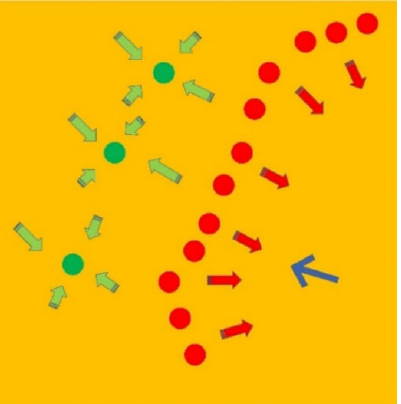
Figure 14. Example of an aquifer where a reversal of seawater incursion is attempted. Green circles = abstraction wells; red circles = infiltration/injection wells; green arrows = abstracted water flows in the aquifer; red arrows = infiltrated/injected water flows of partially desalinated water; blue arrow = direction of seawater